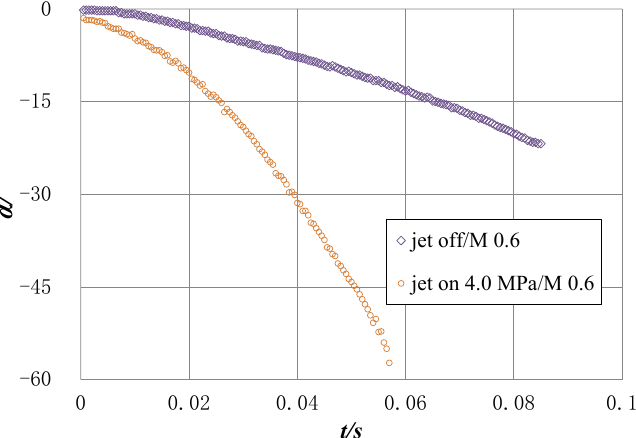
Figure 16. Angle of attack curve of revolution body at M = 0.6 with a jet at 4.0 MPa and without a jet.